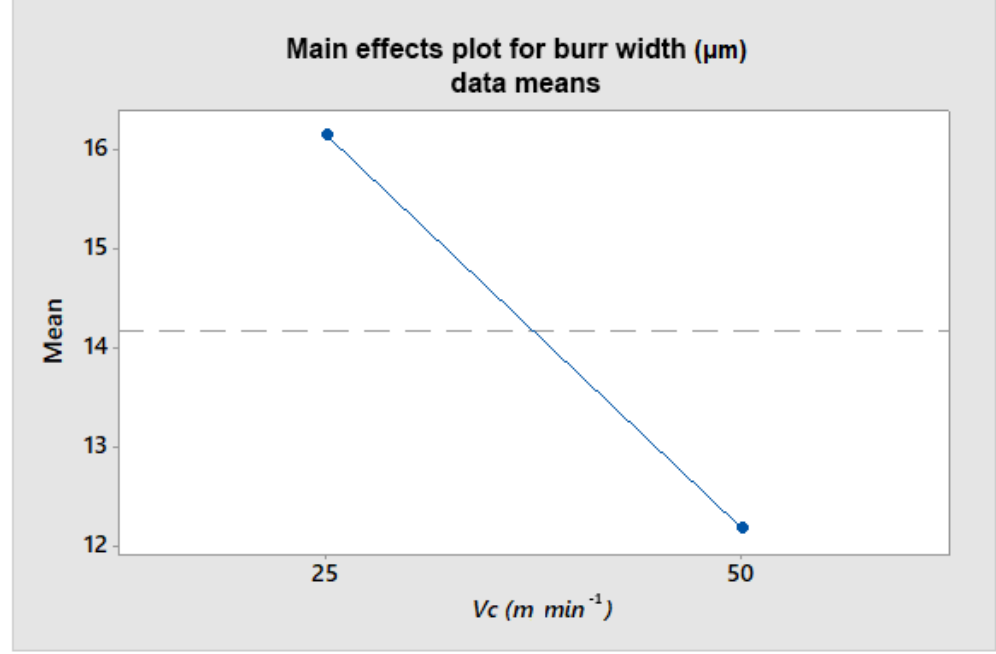
Figure 8. Main effects plot between V c and top burr width (data from Jaffery et al.,